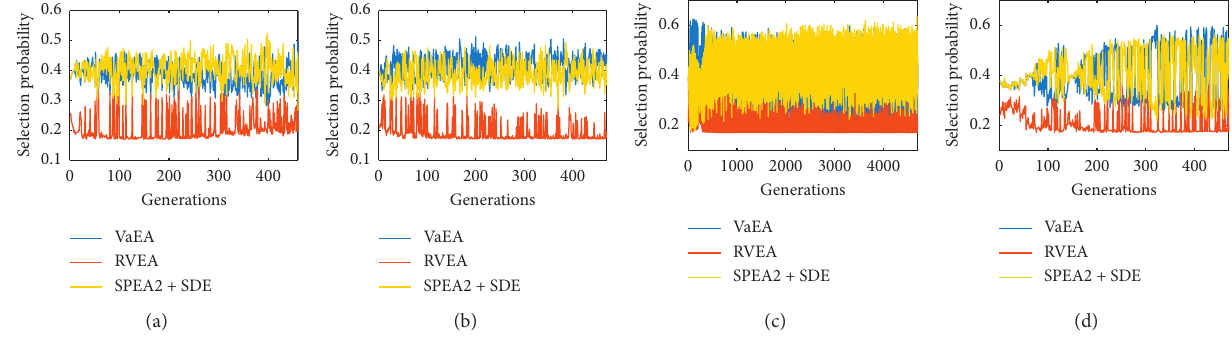
Figure 6: Selection probability fluctuations of three variation operators from the corresponding algorithms during